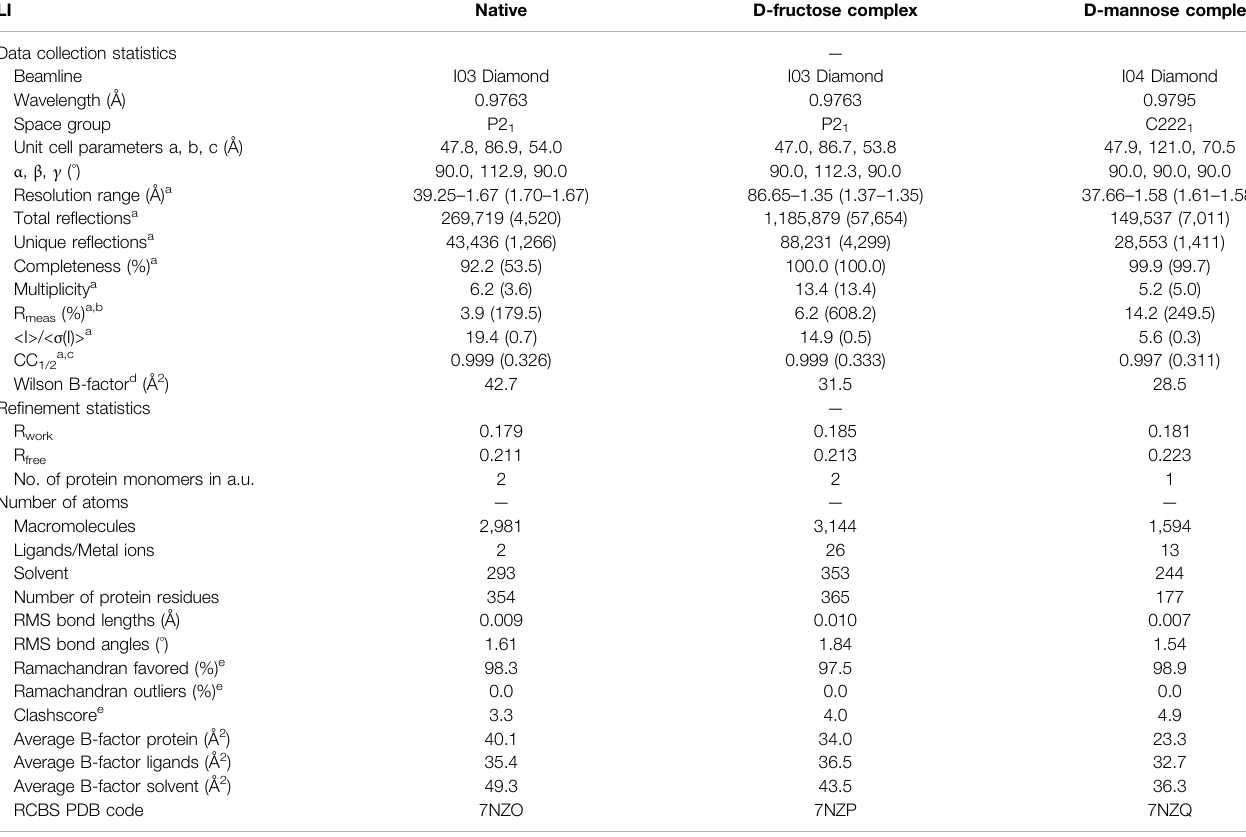
TABLE 2 | The TsLI data processing and structural re fi nement statistics.